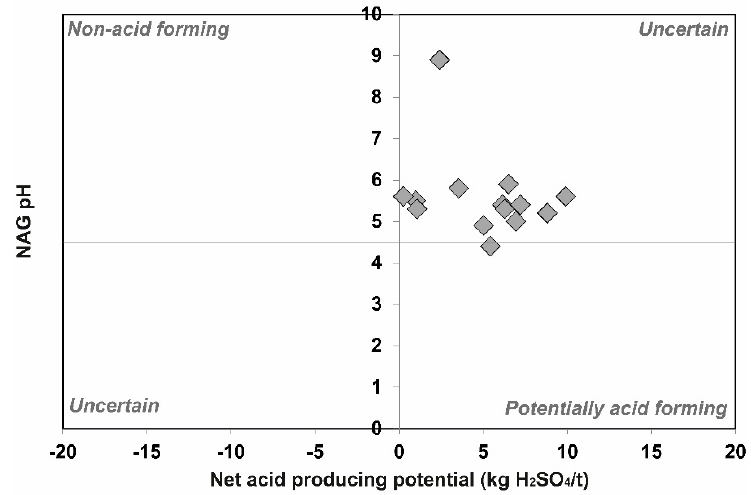
Figure 6. Net acid producing potential vs. net acid generation (NAG) pH plot showing the acid forming characteristics of the heap leach materials ( n = 14).